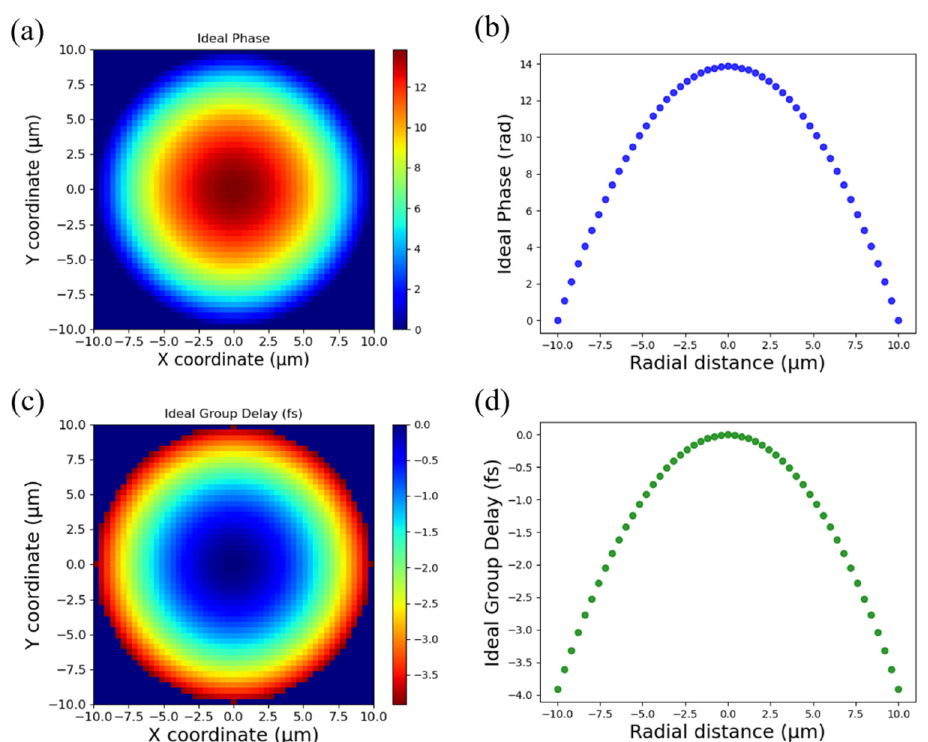
Figure 1. Design of the broadband achromatic metalens. ( a ) Ideal target phase for central wavelength at 532 nm. ( b ) Cross-section of ideal target phase for central wavelength. ( c ) Ideal group delay and ( d ) its cross-section. The aperture of the metalens is 20 μ m, and the focal length is set to 42 μ m.